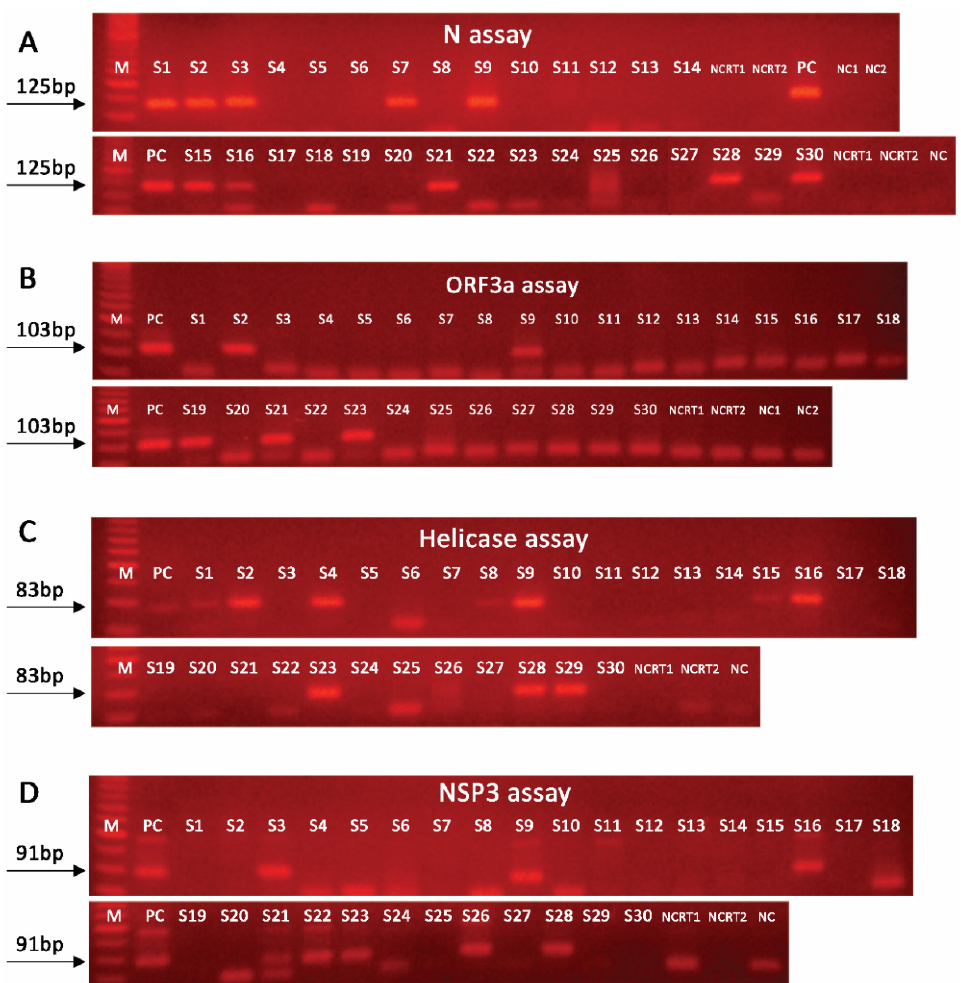
Figure 2. Agarose-gel electrophoresis of the PCR products of our nested PCR assays: ( A ) N assay; ( B ) ORF3a assay; ( C ) helicase assay; ( D ) NSP3 assay, in 30 wastewater samples (S1–S30). M, 50 bp DNA ladder; PC, positive control; NC, PCR negative control; NCRT, reverse transcription negative control.